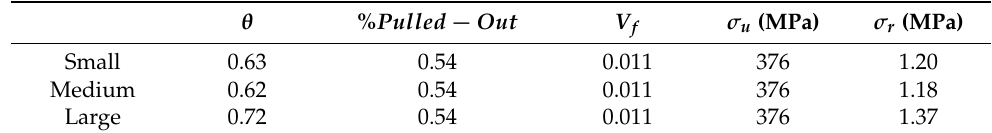
Table 5. Intermediate values for obtaining σ r for all three considered sizes.